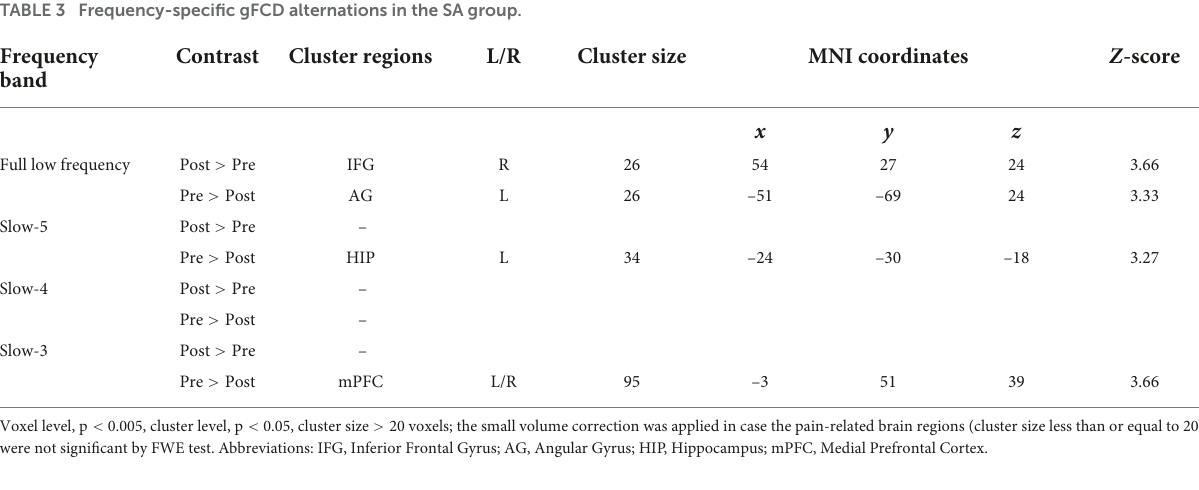
TABLE 3 Frequency-specific gFCD alternations in the SA group.